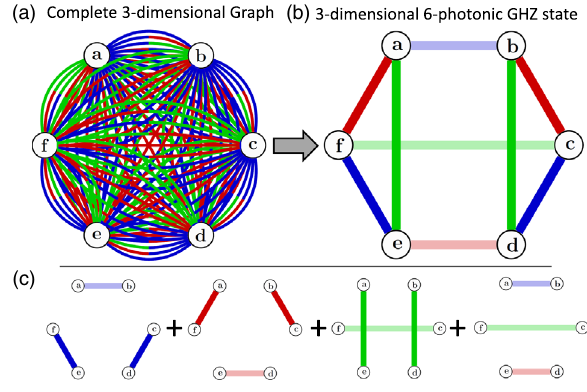
FIG. 3. Finding a three-dimensional six-photonic GHZ state. (a) The initial state is a complete graph of six vertices and three colors. Each pair of vertices is connected by nine edges, which stand for all nine possibilities (blue, red, and green stand for modes 0, 1, and 2, respectively). A bicolored edge stands for a photon pair with different mode numbers. For example, a blue- red edge between vertices a and b stands for a photon pair with one photon in path a with mode number 0 and one photon in b with mode number 1, i.e., a † 0 b † 1 . In total, this procedure leads to 135 edges. (b) The optimized graph for a six-photonic three- dimensional GHZ state. While it has been shown that such a state cannot be created with perfect fidelity [41] with linear optics and probabilistic photon-pair sources (without additional photons), T HESEUS finds a solution where the fidelity scales with F ≈ 1 − O ð ω 4 Þ with the overall counts C scaling as C ≈ O ð ω 2 Þ , which is experimentally feasible. (c) The concept of the solution can be interpreted in the context of graph-theoretical results and can be immediately generalized by human